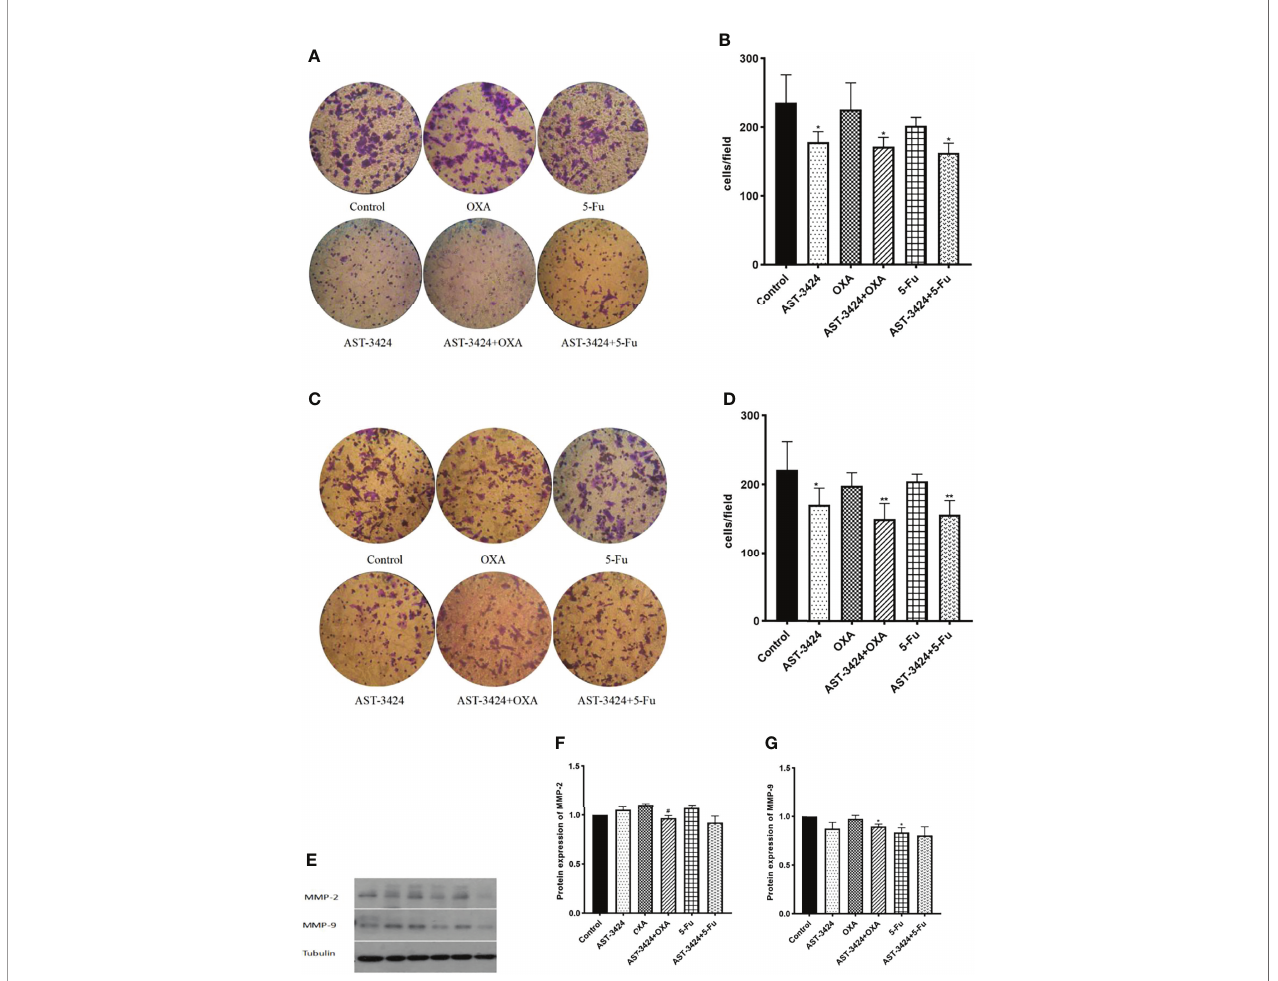
FIGURE 4 | Effects of treatment withAST-3424, OXA, and 5-Fu alone or in combinationwith AST-3424 migratory and invasive abilities of HepG2 cells. (A, B) Representative images of Transwell assayfor invasion using Transwell chambers withMatrigel coating; HepG2 cellsthat had penetratedthroughthe fi lter after treatment with AST-3424, OXA, and 5-Fu monotherapy or in combination for 48 hwere calculated. (C, D) Representative images of Transwellassay for migration using Transwell chambers without Matrigel coating; HepG2 cells that had migrated through the fi lter after treatment with AST-3424, OXA, and 5-Fu monotherapy or in combination for 48 h were calculated. (E – G) Western blot results of MMP-2 and MMP-9 protein expression after treatment with AST-3424, OXA, and 5-Fu alone or in combination, and relative optical density of the proteins was analyzed based on ImageJ. All results are expressed as mean ± SEM of three independent experiments. * p < 0.05, ** p < 0.01, *** p < 0.001, compared to the control group; # p < 0.05, ## p < 0.01, ### p < 0.001, the combination group compared to the AST-3424 monotherapy